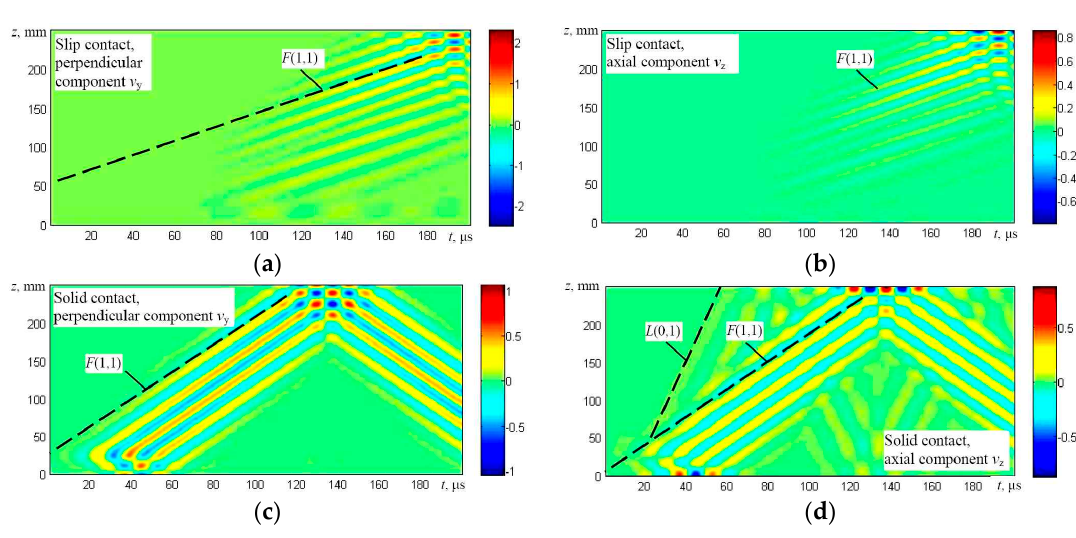
Figure 10. The B-scan images of the particle velocity along the second line of monitoring (the lower surface of the fifth wire) in the case of excitation from the top: particle velocity components v y perpendicular to the axis of the wire ( a ) and v z (longitudinal-axial) ( b ) in the case of the slip contact and the particle velocity components v y perpendicular to the axis of the wire ( c ) and v z (longitudinal-axial) ( d ) in the case of the solid contact between the neighboring wires.